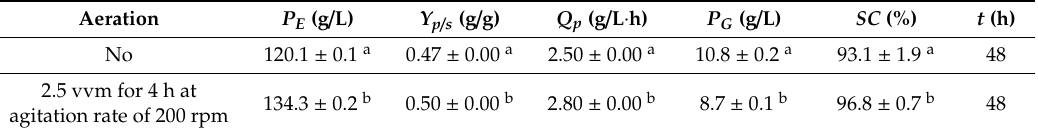
Table 5. Fermentation parameters of ethanol production from the sweet sorghum juice under optimal nutrient conditions ( A 2 B 1 C 3 ) with and without aeration.